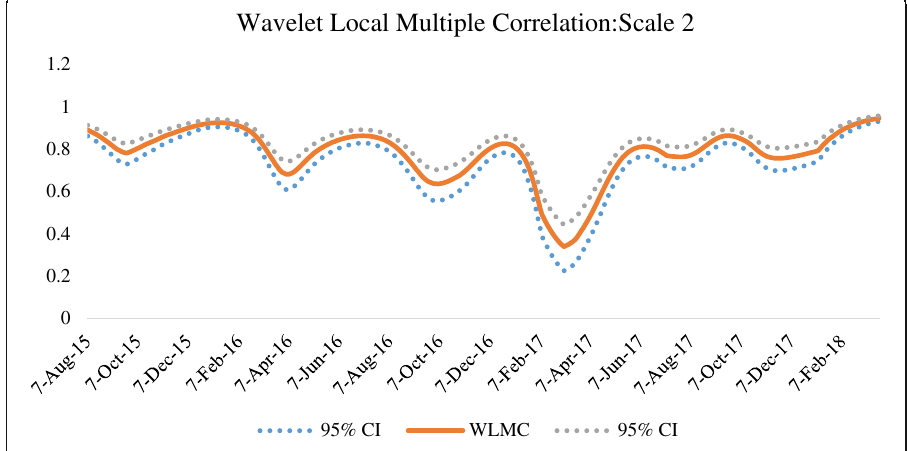
Fig. 5 Wavelet Local Multiple Correlation for Scale 2 (4 – 8 day time period)